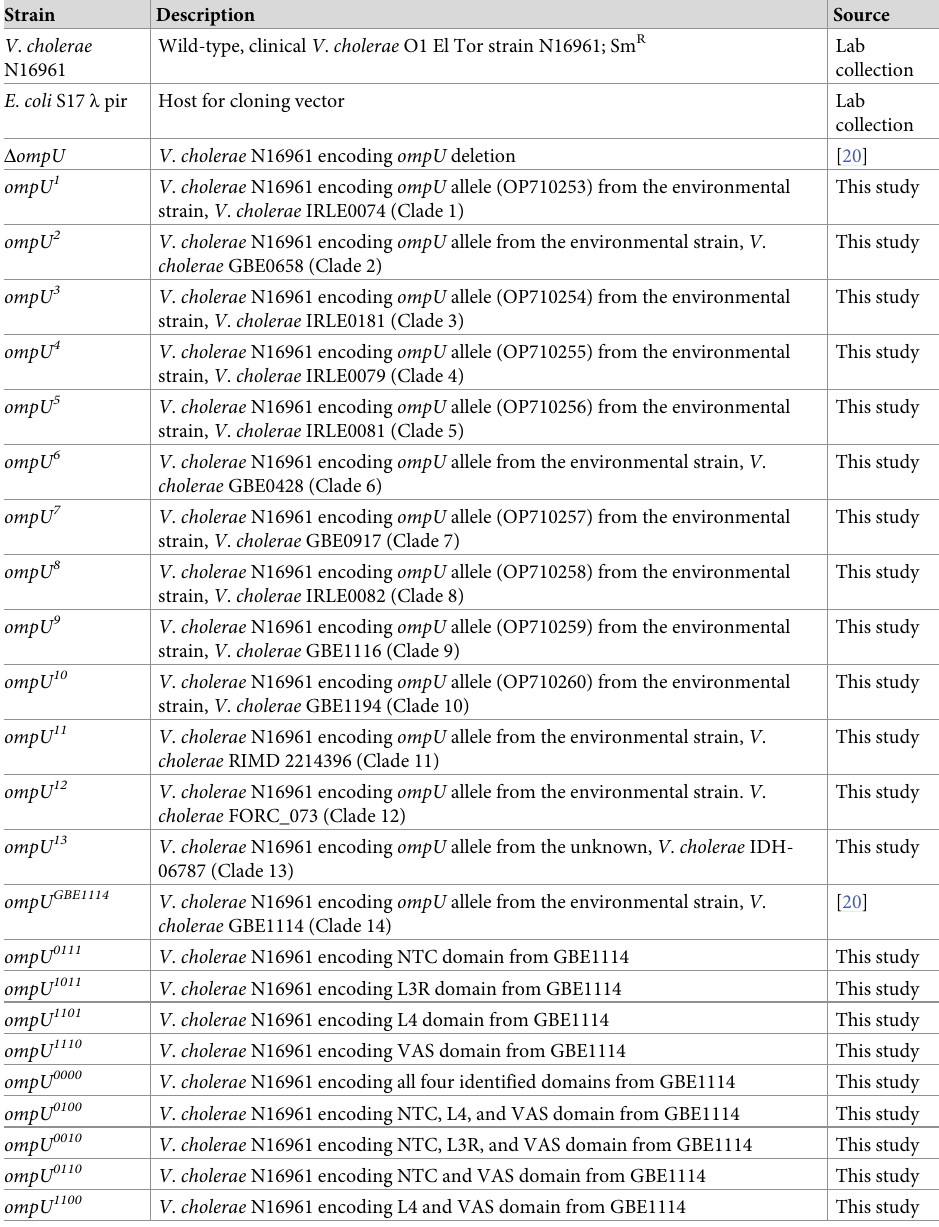
Table 1. Strains used in this